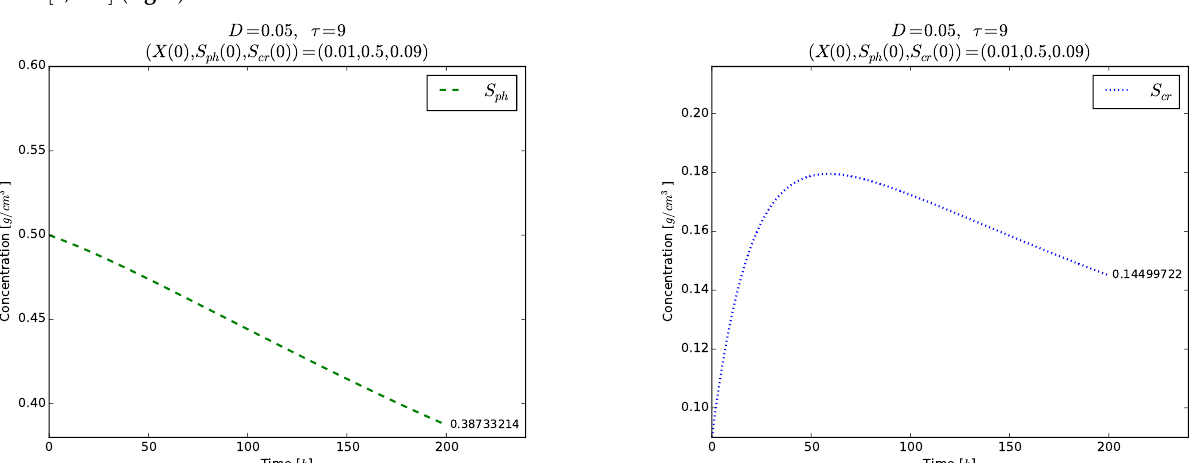
Figure 6. Example 2. Global stability of the equilibrium point E 2 ( left ). Time evolution of the phase variable X ( t ) for t ∈ [ 0,200 ] ( right ).